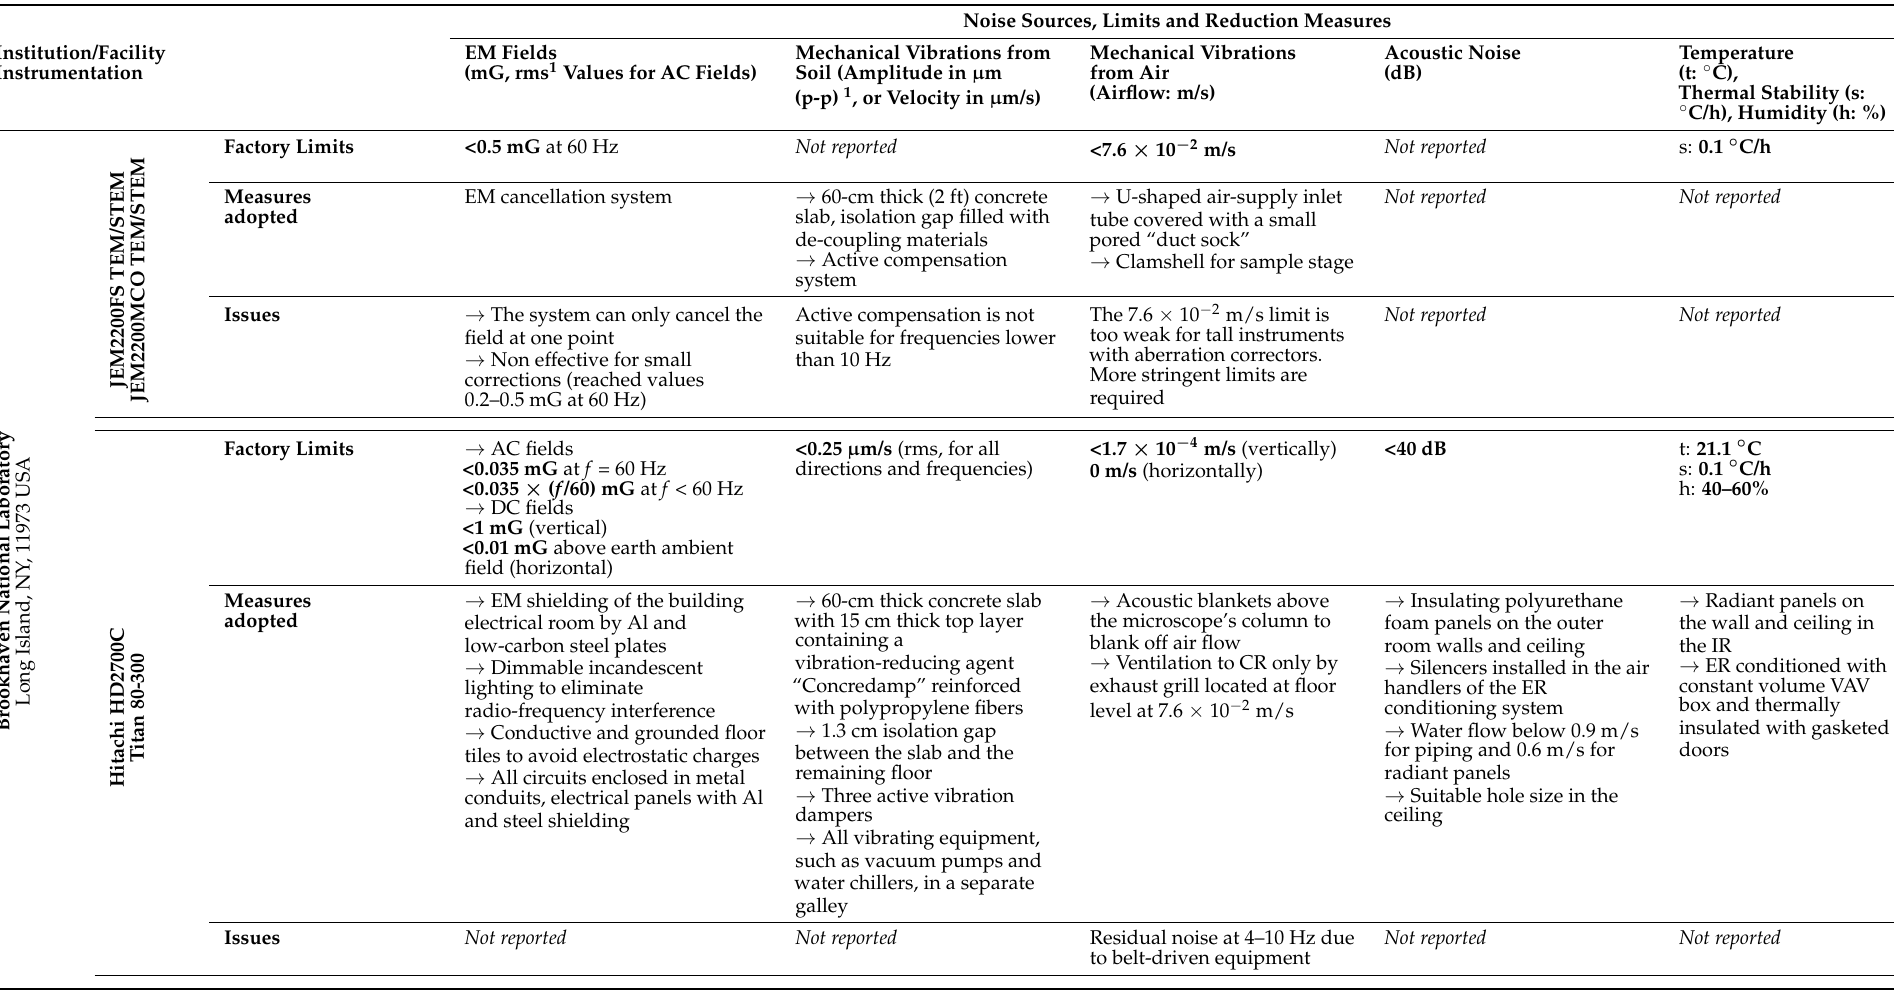
Table 2. Description of measures and strategies to mitigate the noise adopted in the electron microscopy facilities considered in Table